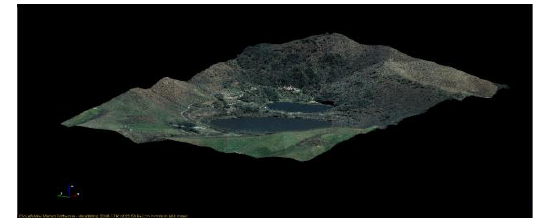
Figure 4. Example of points clouds performed by aerophotogrammetric method with 1 meter